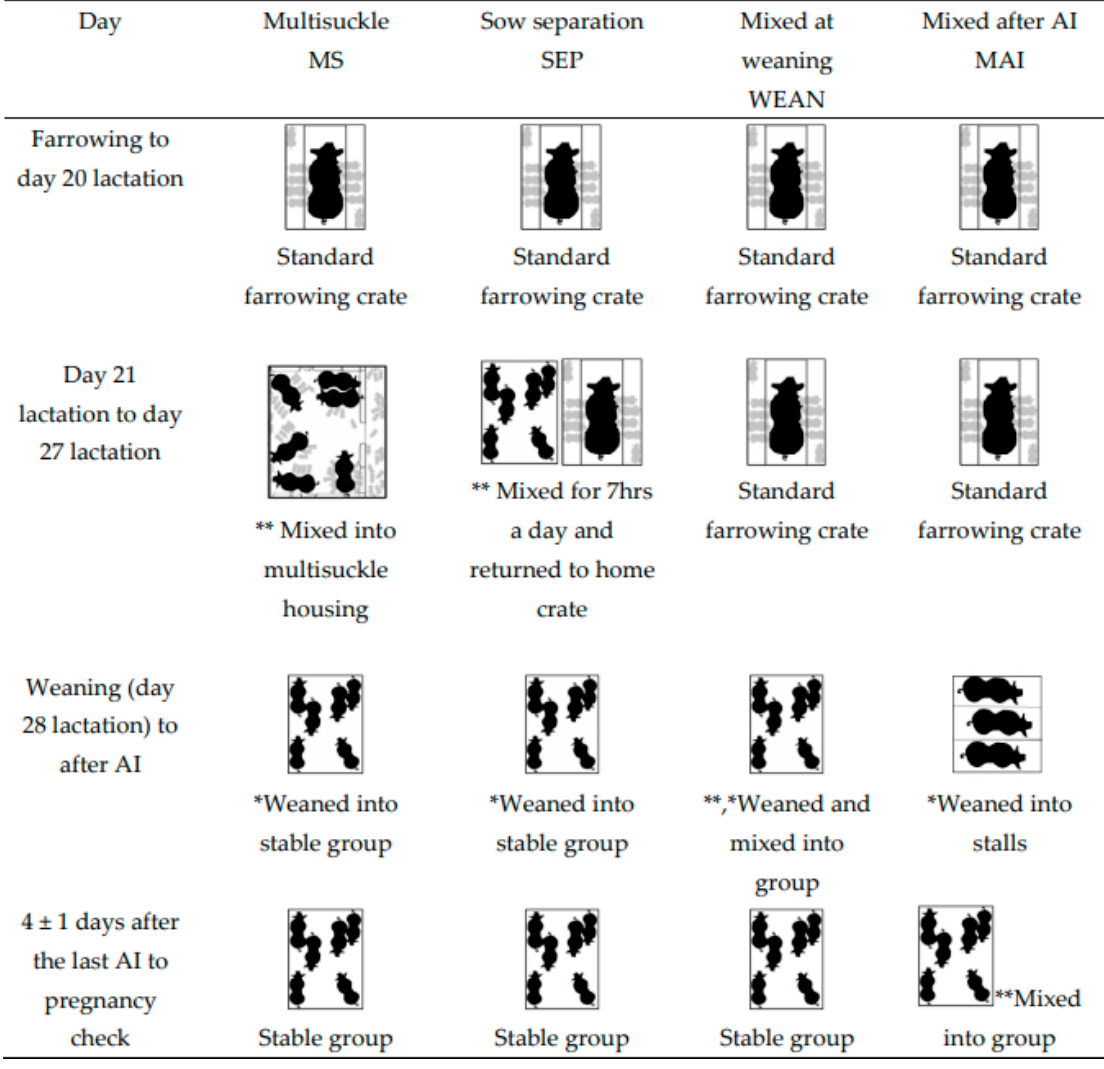
Figure 1. Lactation housing treatments imposed onto sow and piglets 1, * Highlights the timing of weaning stressor, ** highlights the timing of mixing 1 . At weaning (*), all piglets were weaned into one weaner accommodation room.